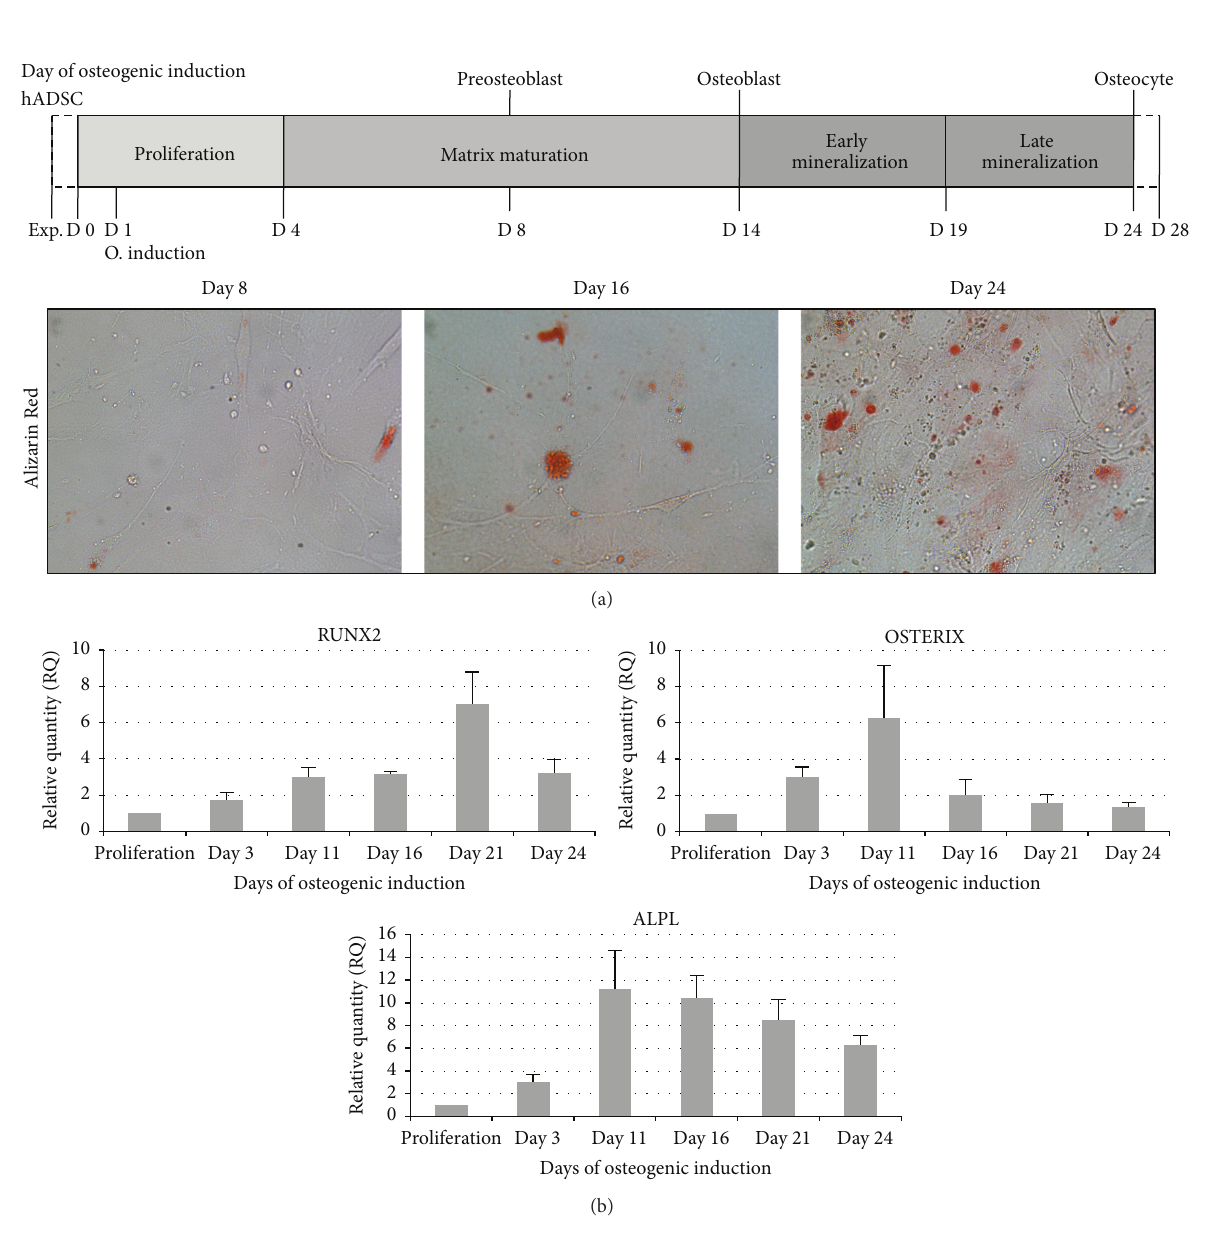
Figure1:(a)AlizarinRedSstainingofhADSCsduringosteogenicdifferentiation.Mineralizationoftheextracellularmatrixwiththepresence of calcium precipitates was visualized by staining with Alizarin Red S at days 8, 16, and 24. (b) Gene expression levels during osteogenic differentiation of hADSCs. Relative quantification of mRNA level assessed by qRT-PCR for RUNX2, OSTERIX, and ALPL after 3, 11, 16, 21, and 24 days of osteogenic differentiation. Proliferation group is used as reference for